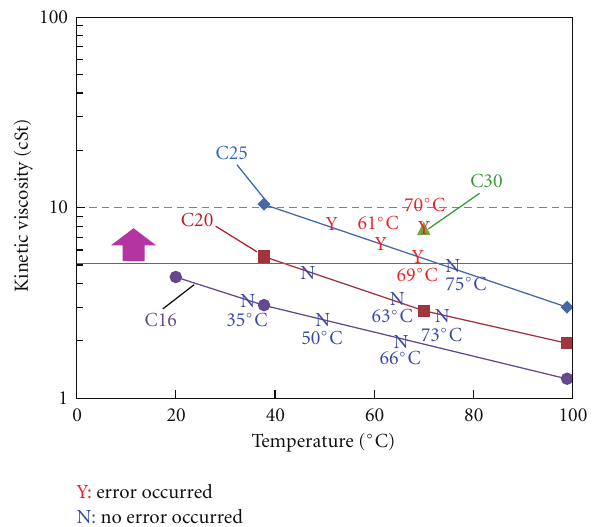
Figure 12: Correlation between kinetic viscosity of alkanes and the occurrence of drive